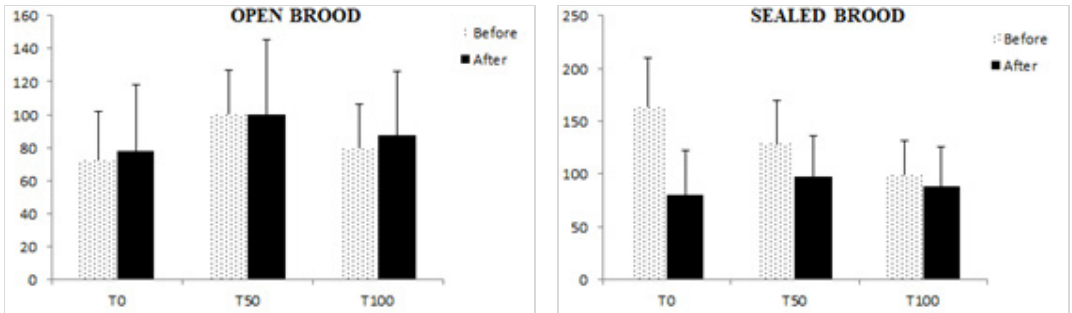
Fig 3 . Open brood and Sealed brood (cm²) before and after transport for not transported (T0) and submitted to transport for 1 hour (T50) and 2 hours